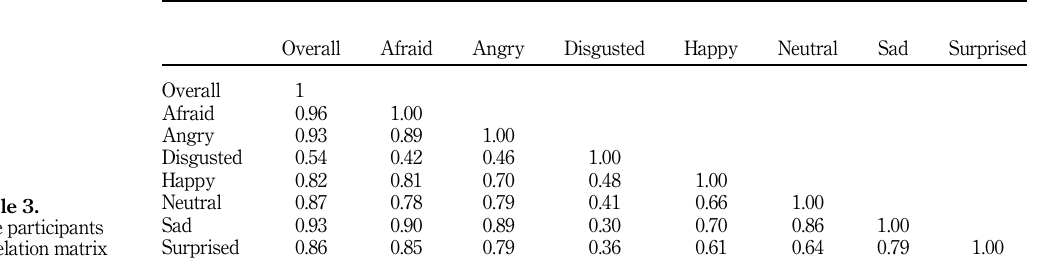
Table 2. Emotions by gender